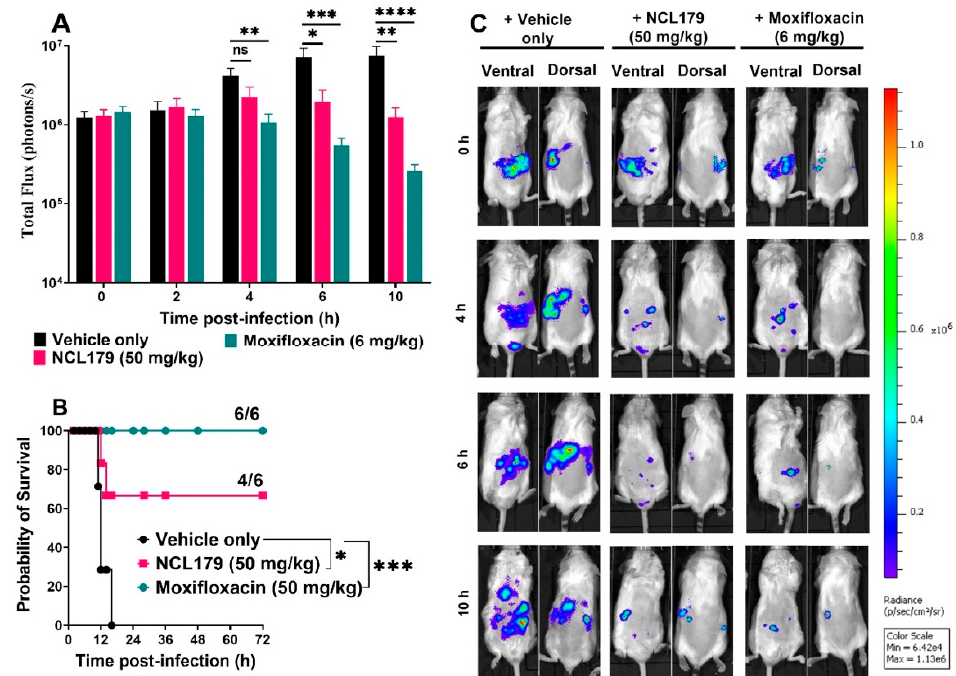
Figure 7. Oral efficacy of 4 doses of NCL179 given 4 h apart in a bioluminescent S. aureus Xen29 sepsis mouse model. ( A ), Comparison of luminescence signals between groups of CD1 mice ( n = 6) challenged IP with Xen29 and treated with NCL179, moxifloxacin and vehicle at 0 h, 4 h, 8 h and 12 h post-infection. Mice were subjected to bioluminescence imaging on IVIS Lumina XRMS Series III system at the indicated times (ns, no significant; *, p < 0.05; **, p < 0.01; ***, p < 0.0002, ****, p <0.0001, Mann-Whitney U -test, two-tailed). ( B ), Survival analysis for mice treated with NCL179, moxifloxacin and vehicle (ns, no significant; *, p < 0.05; ***, p < 0.0002; Log-rank (Mantel-Cox test)). ( C ), Ventral and dorsal images of representative CD1 mice challenged with approx. 3 × 10 7 CFU of bioluminescent S. aureus ATCC 12600 (Xen29). Moxifloxacin used as a control drug was prepared in almond oil at 6 mg/mL by BovaVet, Australia.